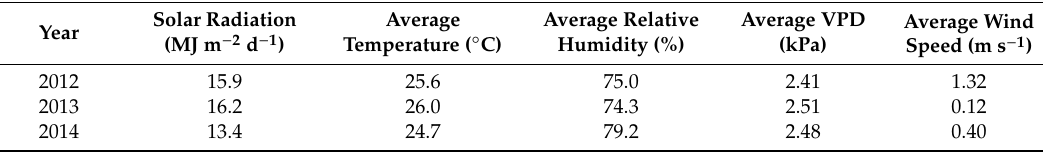
Table 1. Meteorological data at the experimental station during the growing season from May to October in 2012, 2013, and